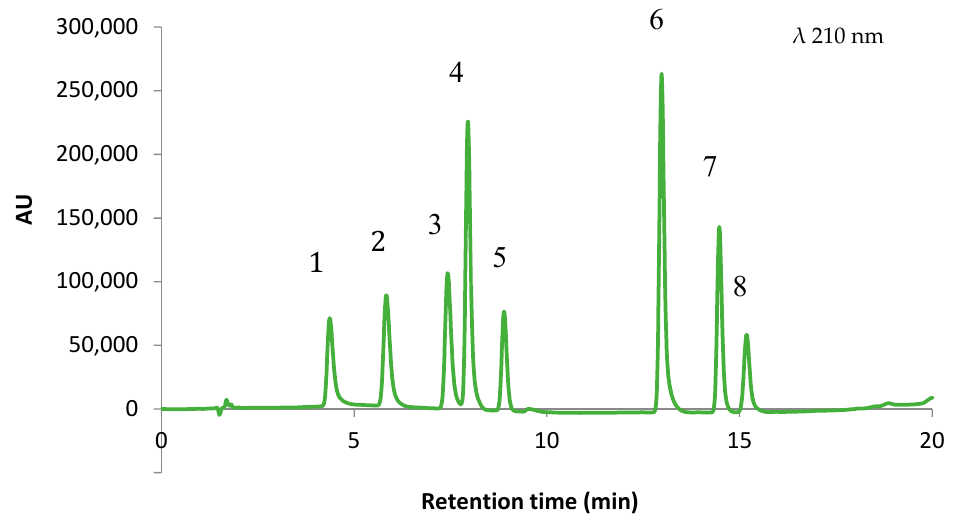
Figure 3. Chromatogram of seven food additives and caffeine using the optimized method for the HPLC-DAD (1. ACE; 2. BEN; 3. SOR; 4. SAC; 5. TAR; 6. CAF; 7. SUN; 8. ASP).